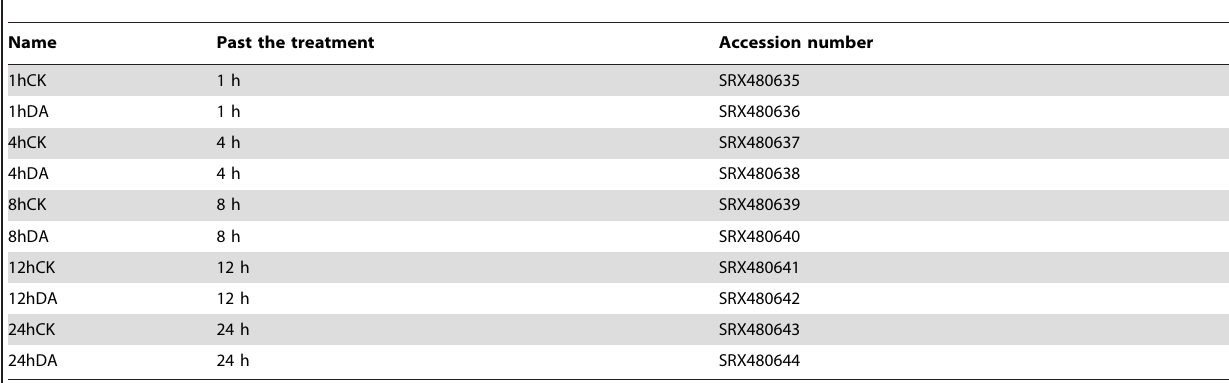
Table 3. NCBI SRA accession numbers for the treatments at each time